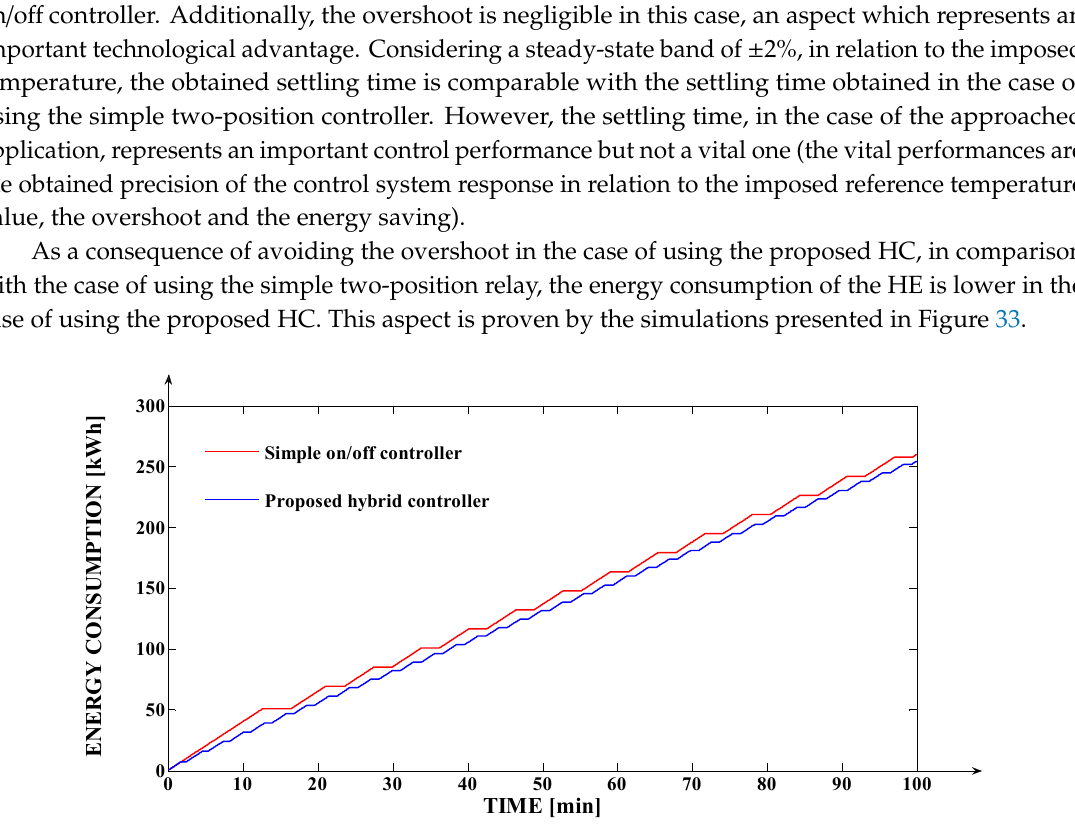
Figure 34. Vibration signal collected by the acceleration sensors for a faulty gear (left) and good gear (right). Fault detection can be implemented based on spectral analysis of the collected digital sequences, as demonstrated in Figure 35. Figure 35. Spectrum comparison for the two vibration signals collected at the level of the wireless hub.